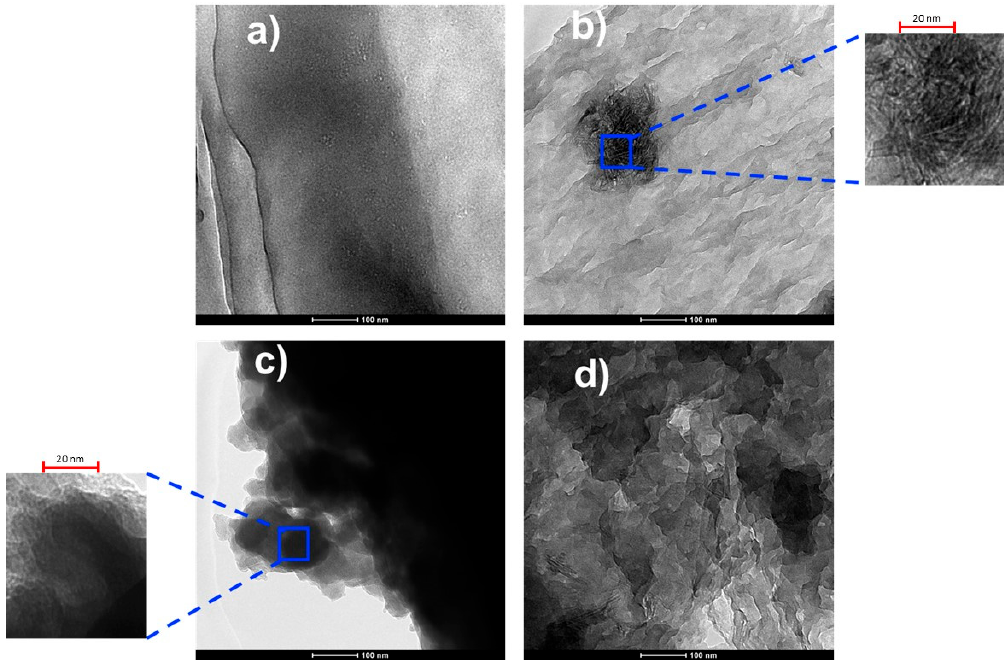
Figure 5. TEM images of surface of: ( a ) PVDF; ( b ) polyvinylidene fluoride/titania nanolayers (PVDF/TNL); ( c ) PVDF/rGO; and ( d ) PVDF/rGO-TNL.